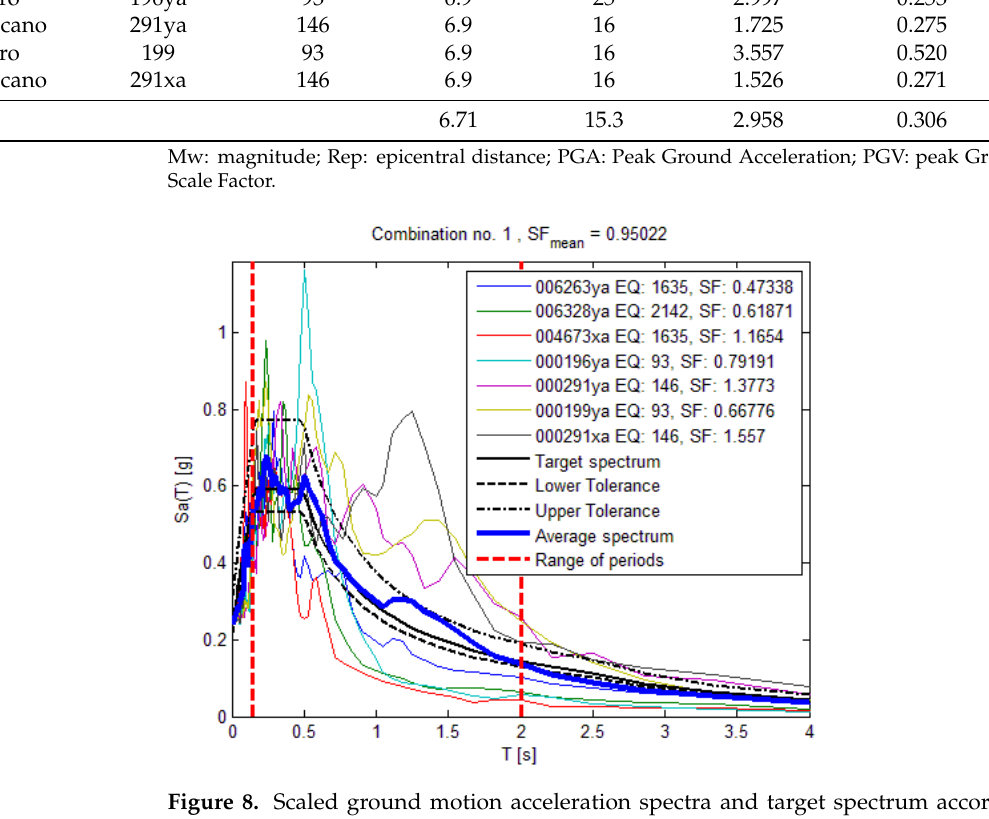
Figure 8. Scaled ground motion acceleration spectra and target spectrum according to the IBC ( ξ = 5%) [33].